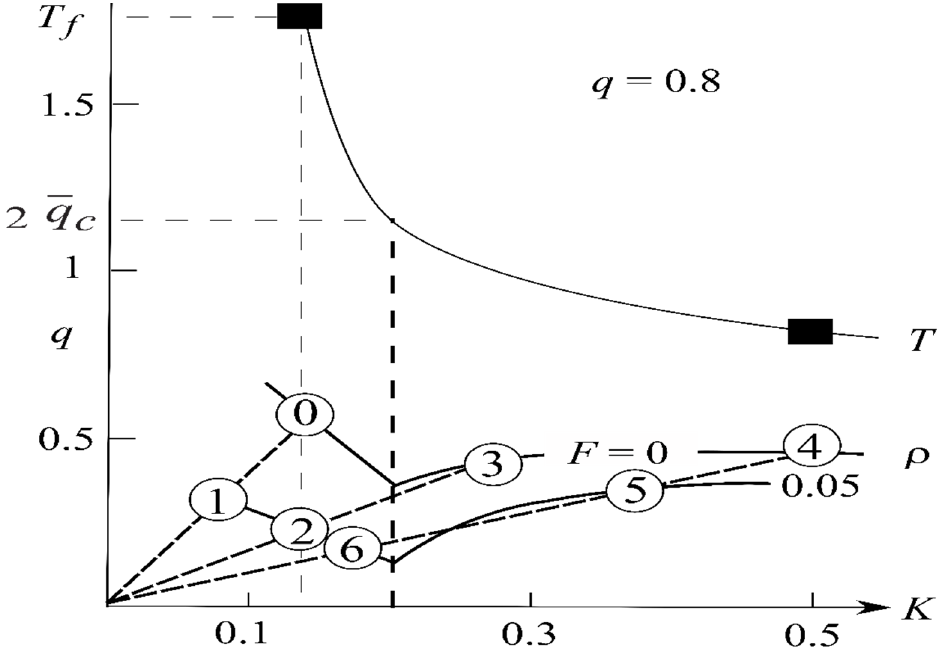
Figure 9. Same as Figure 5 but for 𝑞 = 0.8 to illustrate genesis of the deglaciation (arrows are neglected for clarity).